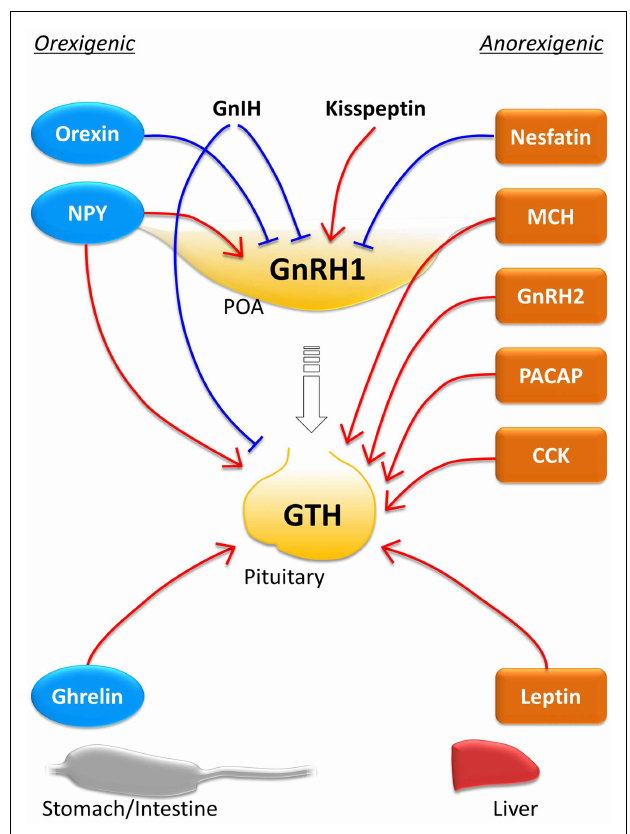
FIGURE 1 | Effects of central and peripheral metabolic hormones on the reproductive system .The hypothalamus–pituitary axis receives many stimulatory and inhibitory inputs from central metabolic neuropeptide neurons and peripheral metabolic signals to control the reproductive system according to the energy status.The hormones indicated with blue circles are orexigenic hormones, while those with orange squares are anorexigenic ones. Red lines indicate stimulatory action and blue lines indicate inhibitory action. Most anorexigenic hormones stimulate gonadotropin secretion at the pituitary level. In the goldfish, NPY and ghrelin, which act as orexigenic hormones, also stimulate the reproductive system at the brain and pituitary levels. It should be noted that this figure is drew primarily based on the information obtained from the goldfish. Function of each metabolic hormone might differ in different species [e.g., Ghrelin functions as an anorexigenic factor in the rainbow trout (147) and GnIH stimulates GTH subunit mRNA expression in the puffer fish (97) and the sockeye salmon (92).]. CCK, cholecystokinin; GnIH, gonadotropin-inhibitory hormone; GnRH, gonadotropin-releasing hormone; MCH, melanin-concentrating hormone; NPY, neuropeptide-Y; PACAP, pituitary adenylate cyclase-activating